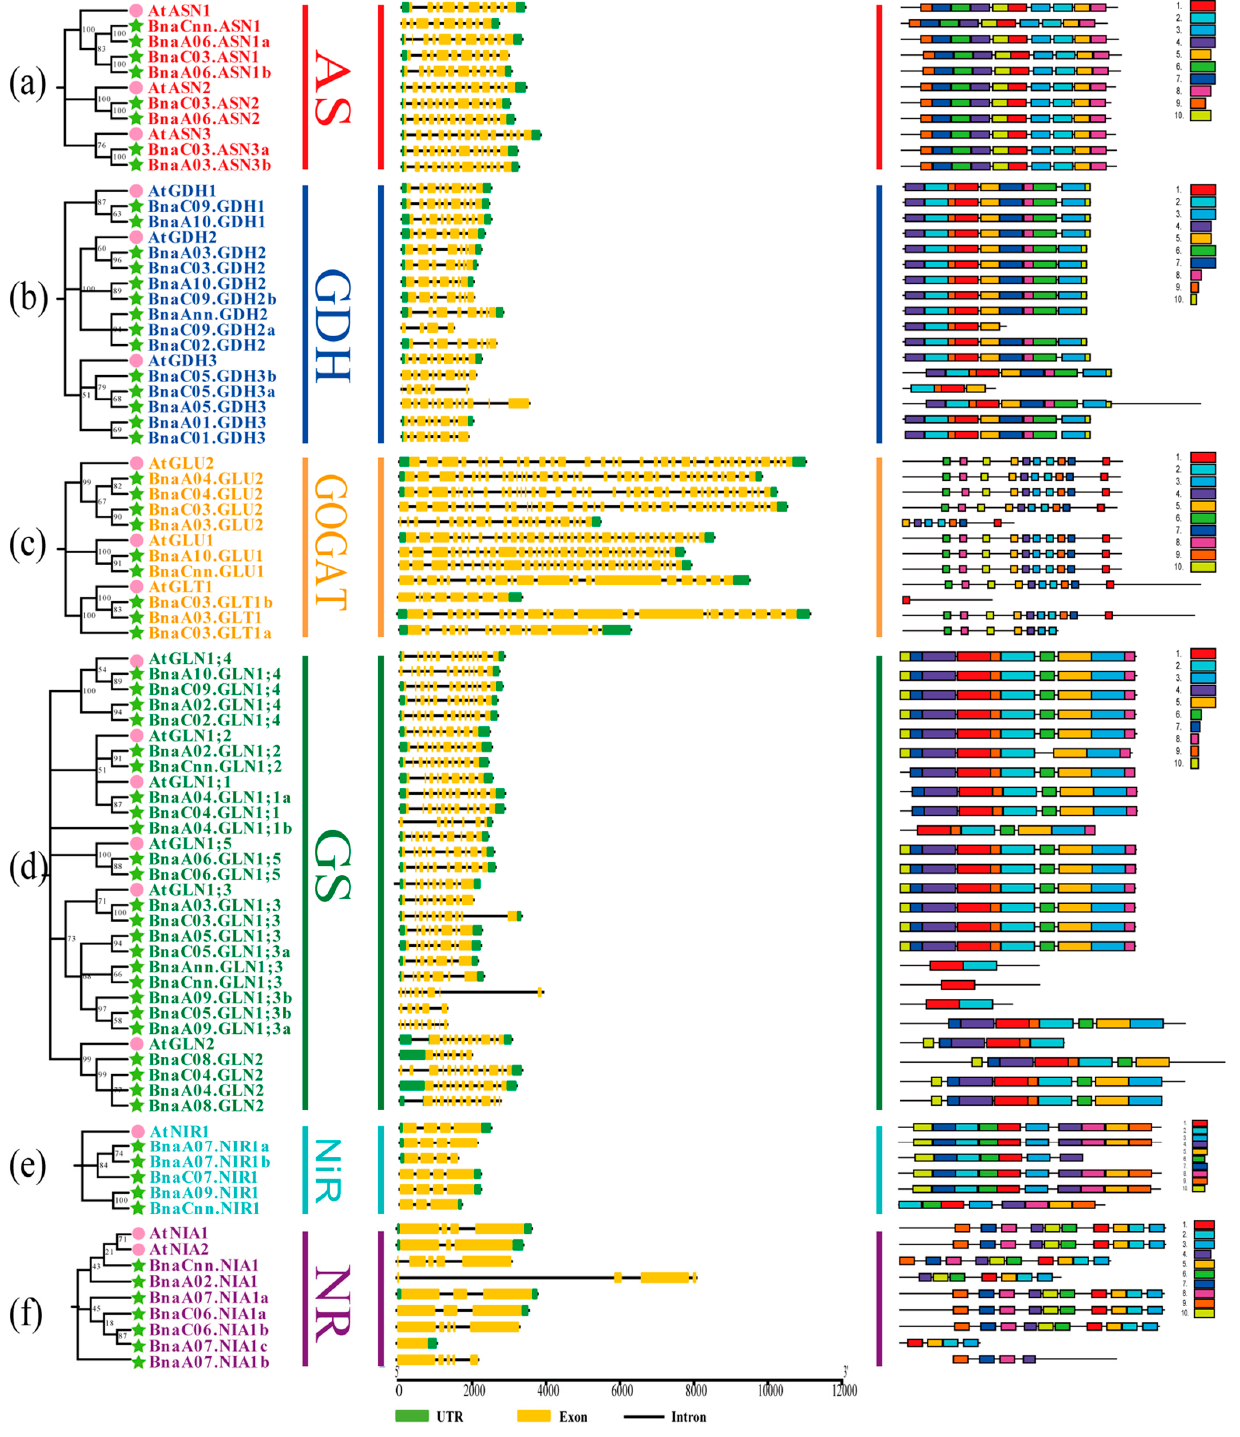
Figure 2. Phylogenetic relationships, gene structure and architecture of conserved protein motifs in the nitrogen assimilation-related genes of Brassica napus and Arabidopsis thaliana . The analysis includes AS ( a ), GDH ( b ), GOGAT ( c ), GS ( d ), NiR ( e ) and NR ( f ) families. The MEGA7.0 software is used to construct the phylogenetic trees with the NJ method. The intron analysis is carried out with genomic and coding sequences of the Arabidopsis and rapeseed NAGs. Exon-intron structure is indicated by yellow rectangles and black lines, respectively. The untranslated region (UTR) is shown by green box. Conserved motifs are detected using MEME, and the boxes with different colors indicate different conserved motifs. The motif sequence information is provided in Table S2. AS, Asparagine synthetase; GDH, Glutamate dehydrogenase;